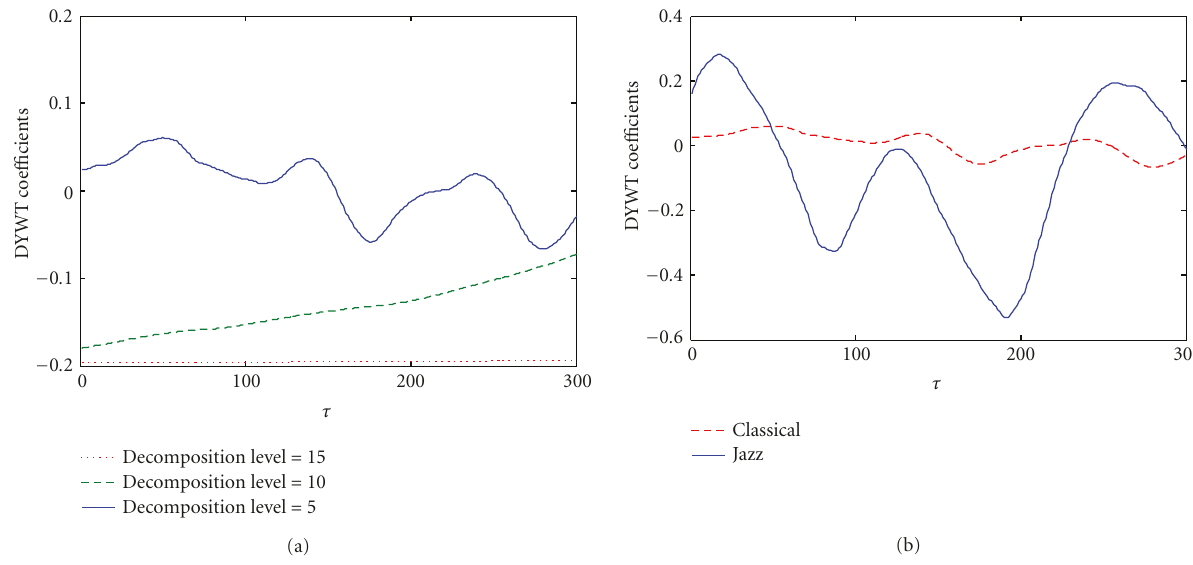
Figure 9: (a) Fluctuation comparison between DYWT coe ffi cients of di ff erent decomposition level, (b) fluctuation comparison between DYWT coe ffi cients of di ff erent clips under the same decomposition